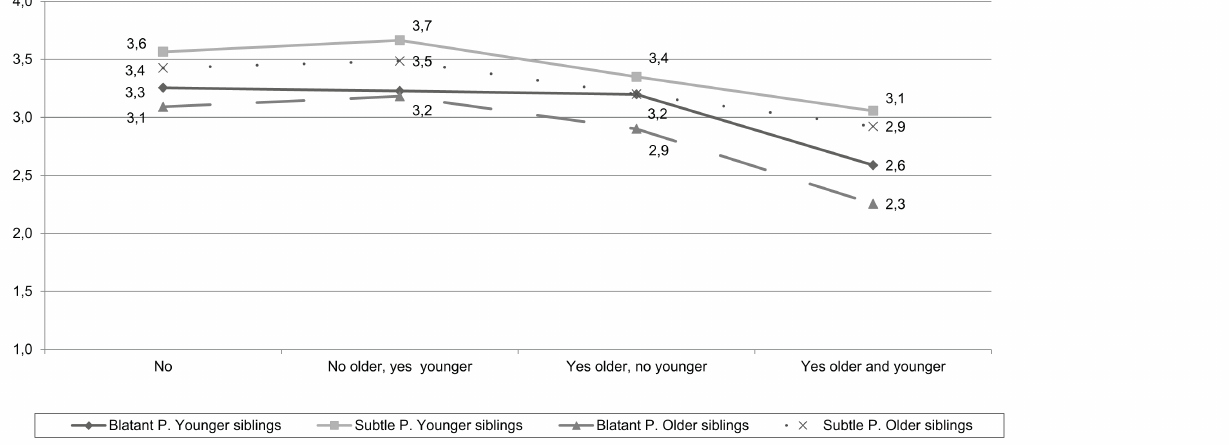
Figure 2. Means of siblings’ blatant and subtle prejudice with respect to four